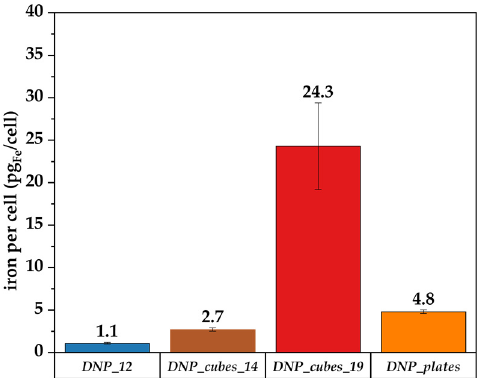
Figure 10. Iron content in FaDu determined by Perls’ Prussian blue colorimetric method after their incubation with DNP_12, DNP_cubes_19, and DNP_plates for 24 h and at an iron concentration of 100 µg/mL.